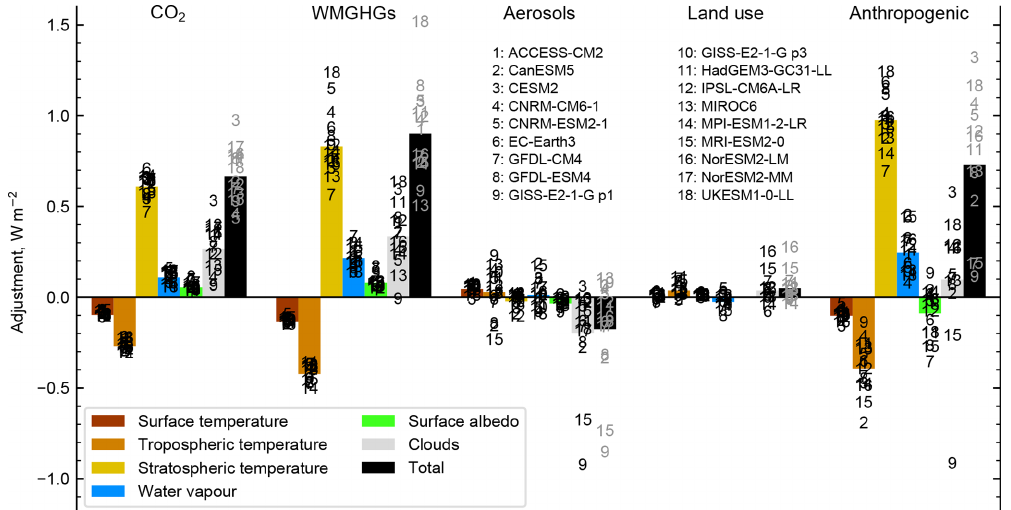
Figure 3. Adjustments broken down by mechanism in each of the present-day RFMIP-ERF time-slice experiments. Black and grey numbers indicate individual models; coloured bars indicate the multi-model